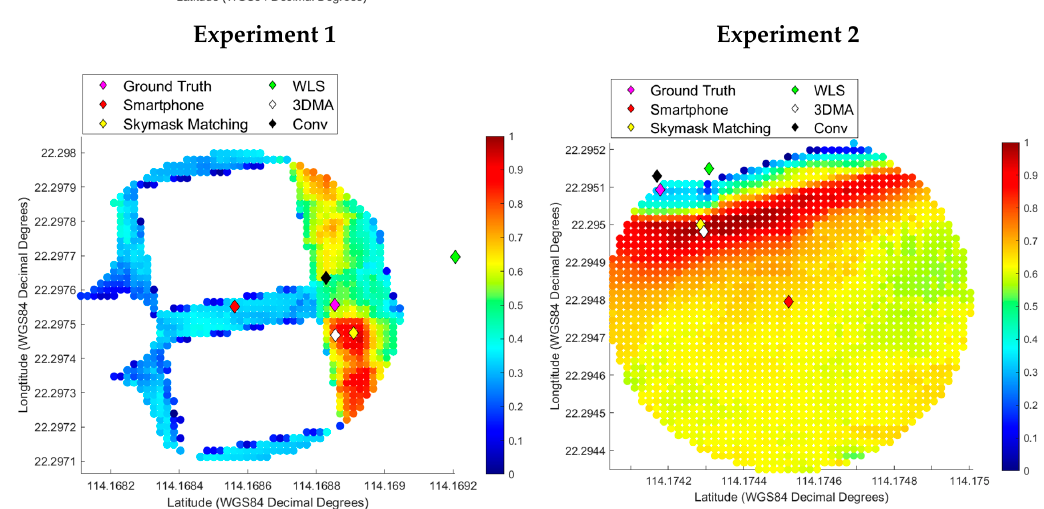
models based on the proposed skymask matching algorithm.